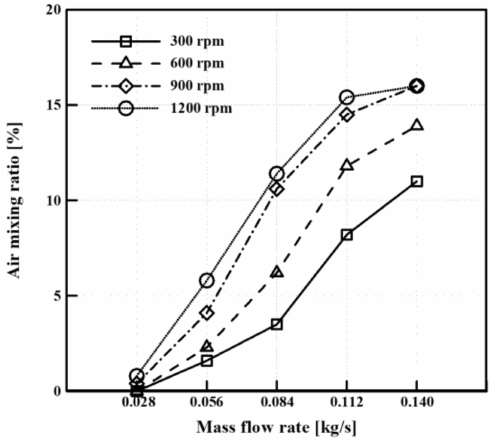
Figure 10. Air mixing ratio according to the mass flow rate at 60 ◦